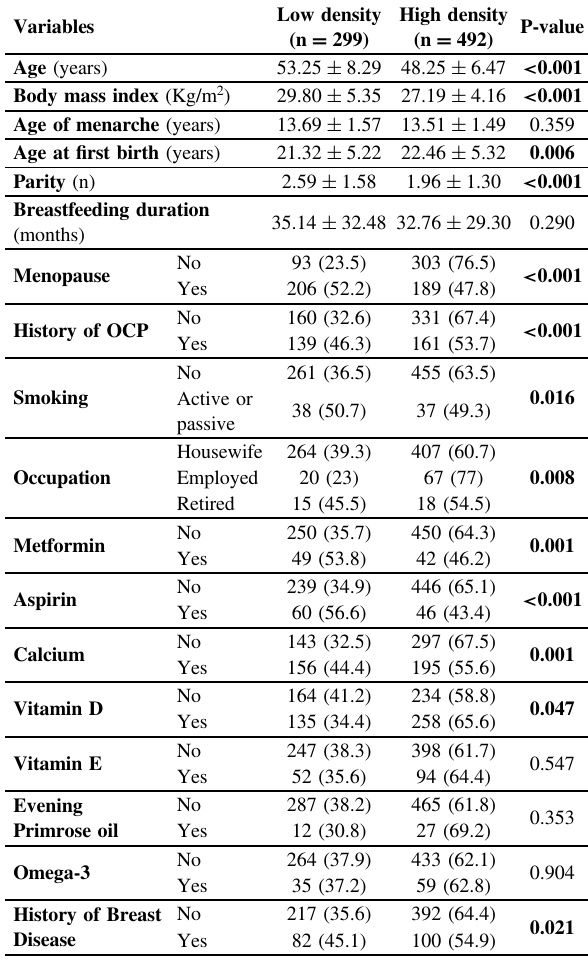
Table 1 Demographic, medical and drug history of women with high and low mammographic breast